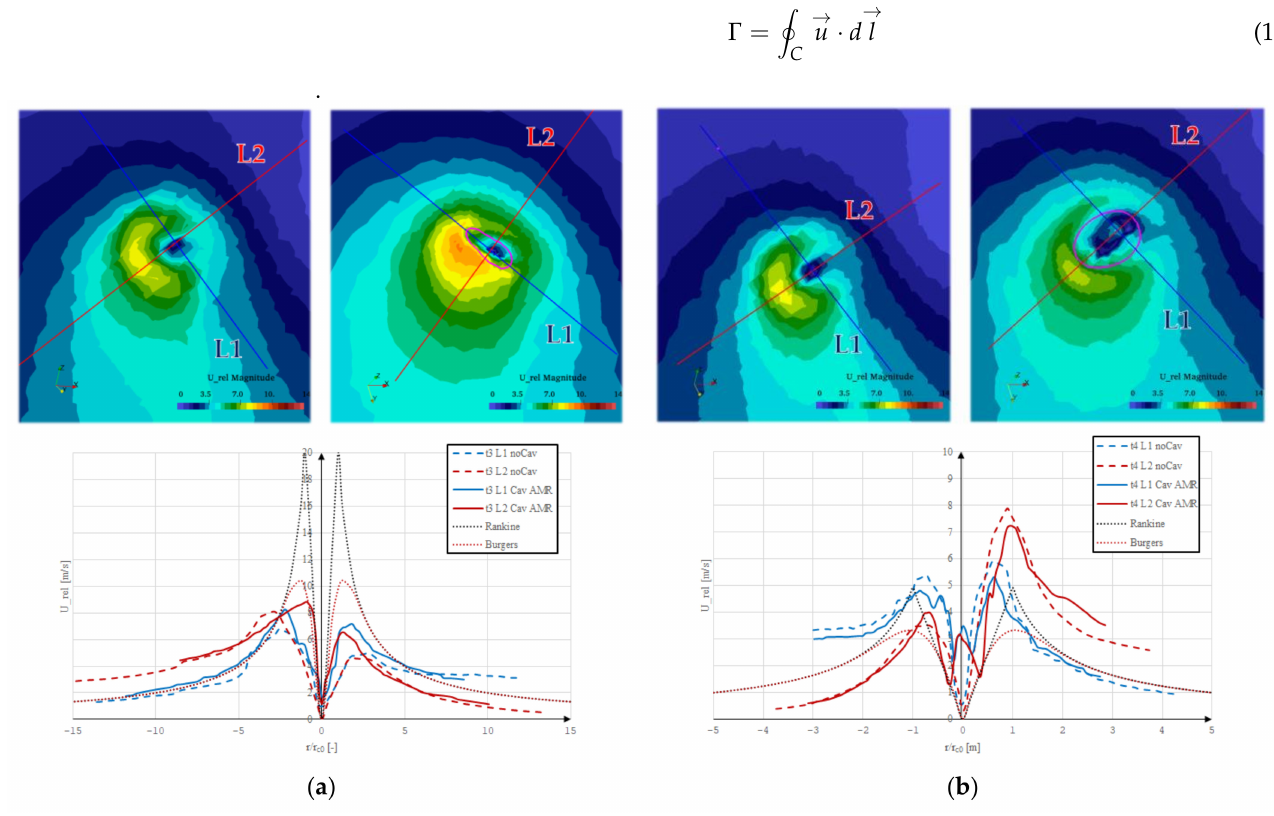
Figure 8. PPTC’11. Comparison of relative in-plane velocity with inviscid 2D analytical vortices angular velocity: ( a ) station t 3 ; ( b ) station t 4